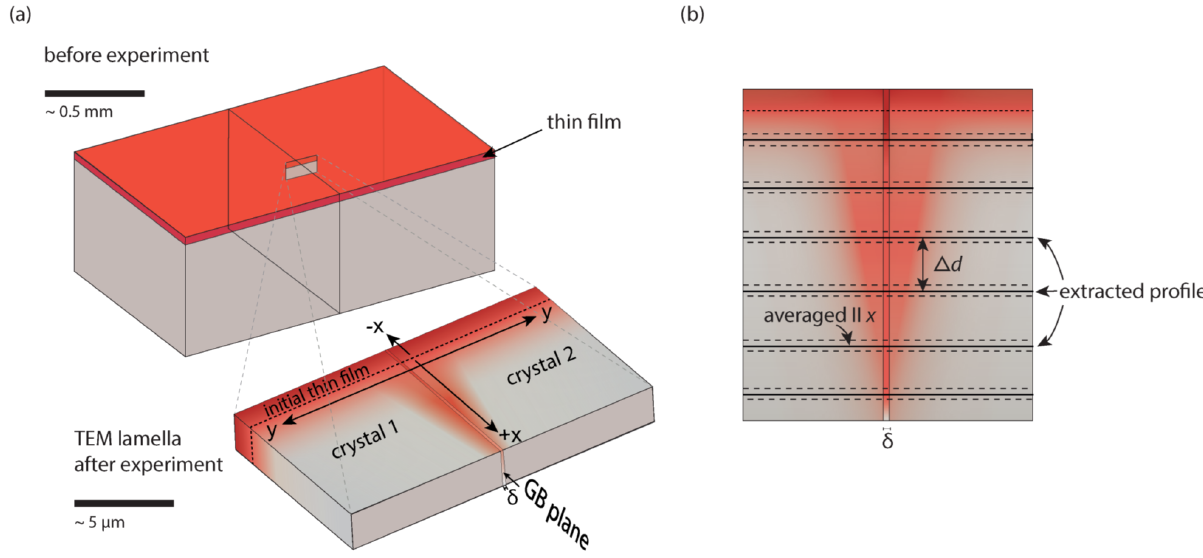
Figure 1. Schematic bi-crystal. (a) Experimental setup with thin film (upper drawing) and close-up of electron transparent TEM lamella produced by FIB used for analyses. The TEM lamella exemplifies a specimen after a diffusion experiment. Compositional differences are indicated in variations of red. (b) Schematic of the experimental geometry indicating our definition of the measurement direction. The diffusion profiles across the grain boundary were extracted in equal distances (cid:49) d matching the length of the lamella. The diffusion profiles were integrated parallel to the x direction; this is illustrated schematically by dashed lines. Additionally, profiles along the grain boundary were extracted.